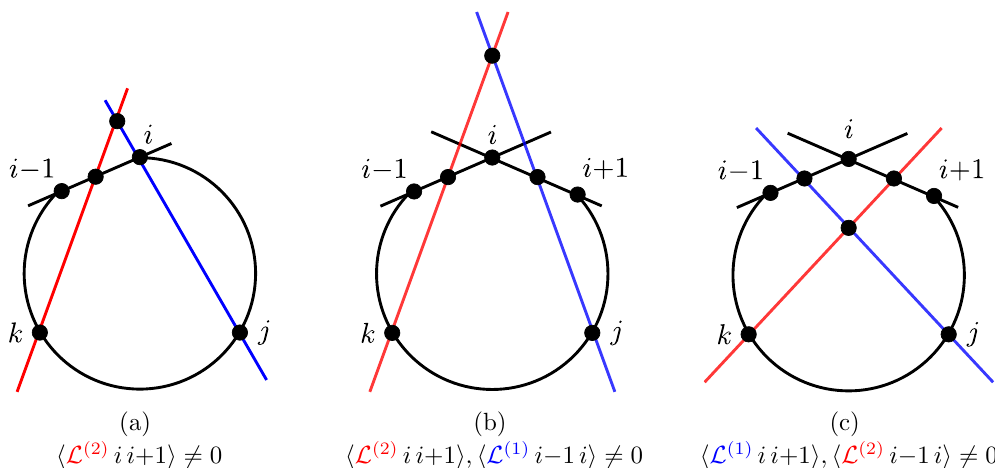
Figure 4. Three di(cid:11)erent invalid relaxations of the maximal codimension boundary shown in (cid:12)gure